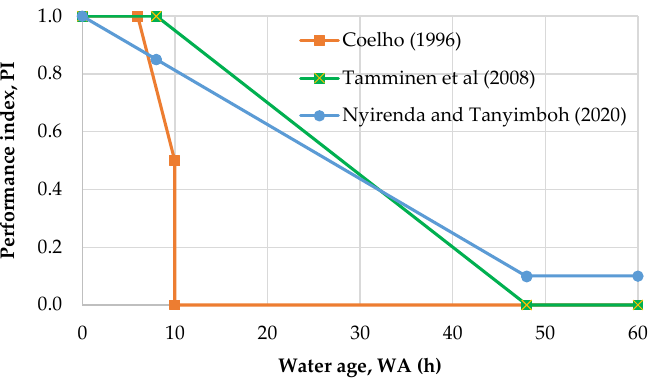
Figure 1. Comparison of the existing water age performance curves.